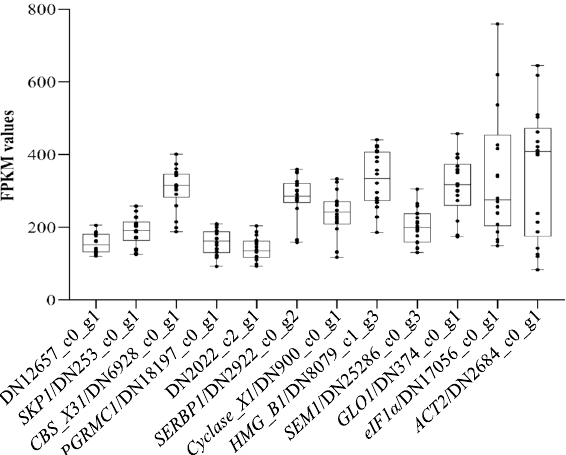
Figure 2. Expression levels of candidate RG and controls across various tissues based on the RNA-Seq data. The mean (horizontal line), upper and lower quartiles (white boxes), maximum and minimum values (whiskers), and each sample (black dots) are shown for individual gene.